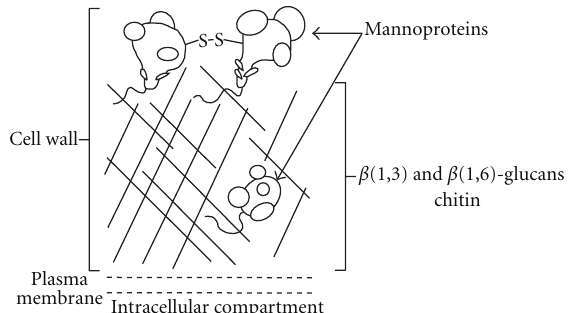
Figure 7: Schematic representation of S. cerevisiae cell wall, adapted from Stone et al.